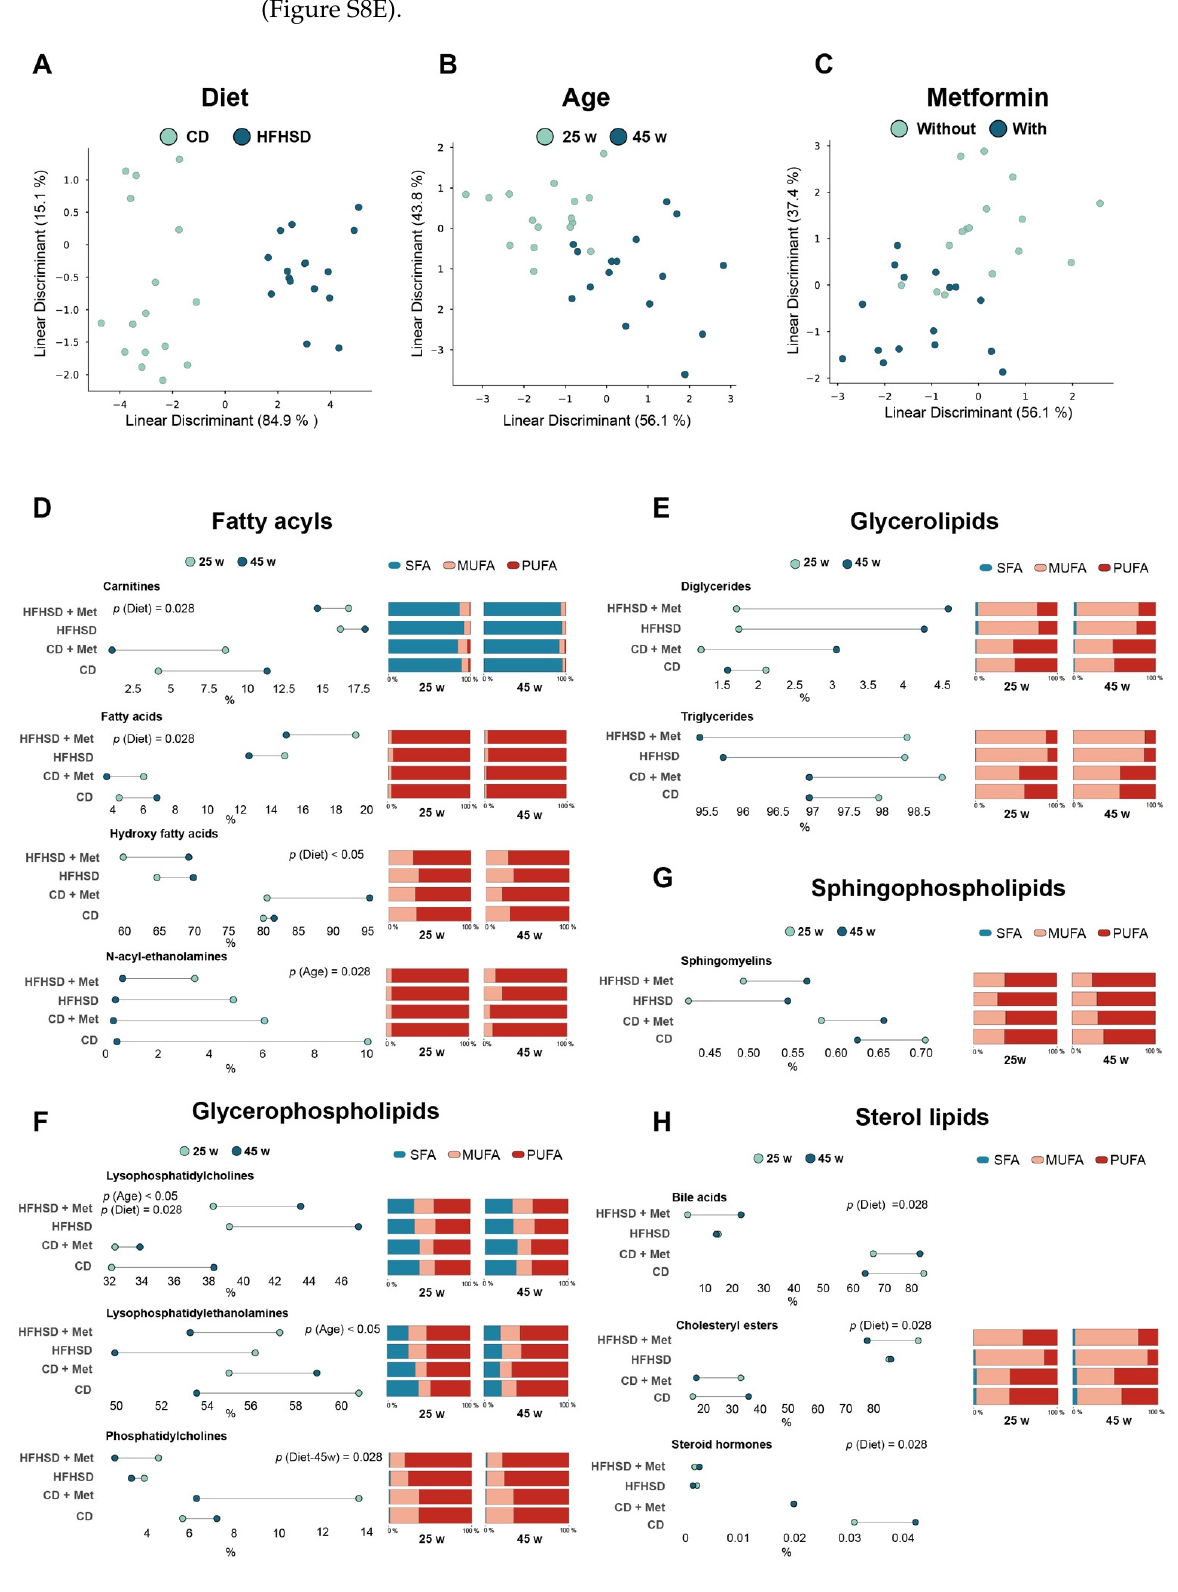
Figure 2. Hepatic lipid remodeling in mice, segregated by diet, age, and metformin: ( A – C ) Linear discriminant analysis (LDA) showing the lipid signature of liver tissue according to dietary type,